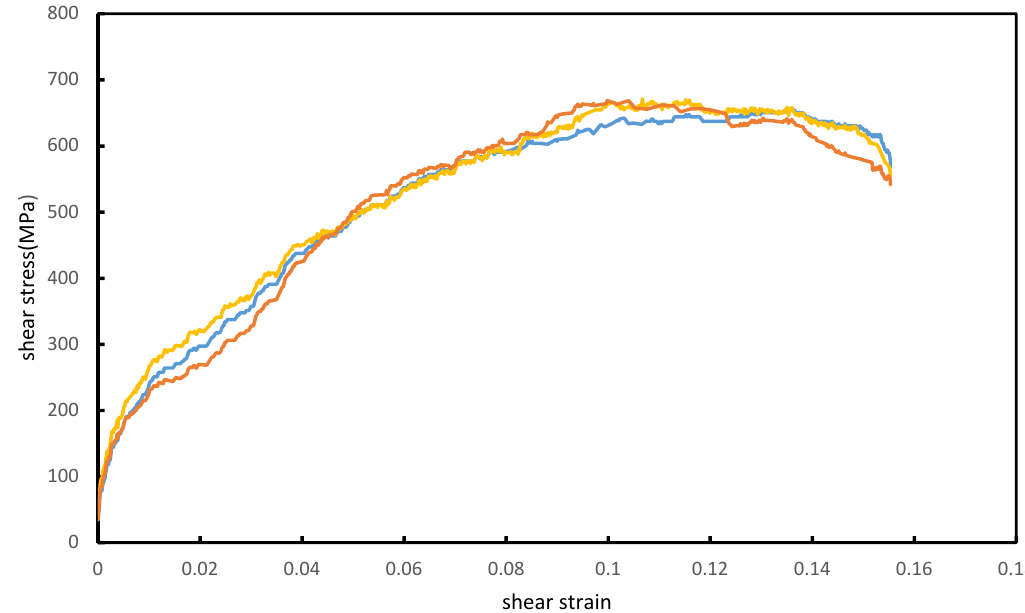
Figure 9. Three shear stress–strain curves of the NSSS under the same strain rate (900 s − 1 ).